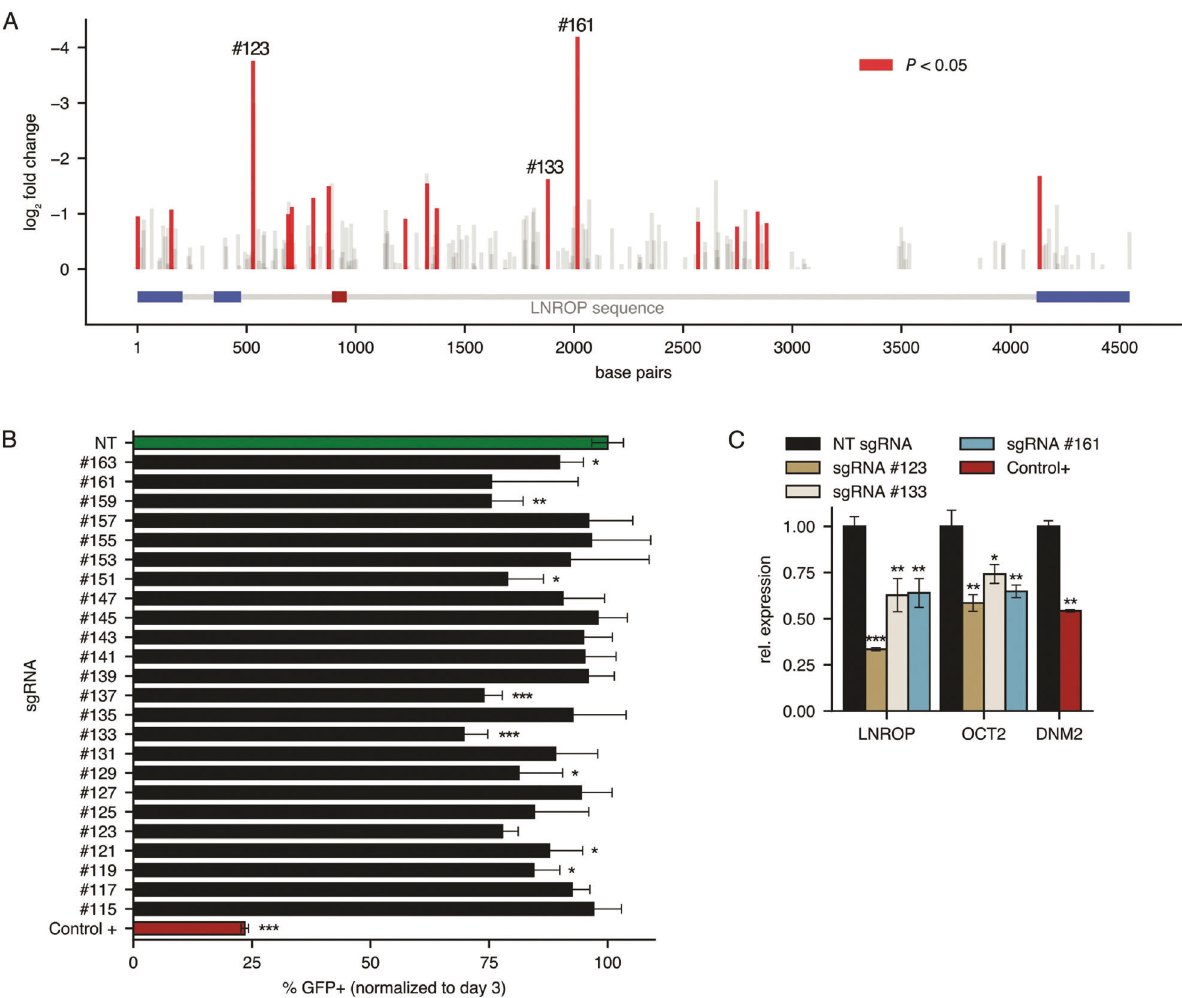
Fig. 2 Phenotypic characterization and OCT2 expression analysis after targeting LNROP using CRISPR-Cas9. A Schematic representation of the sgRNAs library used to target LNROP in RAMOS cells stably expressing active Cas9. Bars correspond to individual guides, and they are represented according to their position over LNROP sequence where introns are colored in grey, exons in blue and MIR4323 in red. Bar height corresponds to the log 2 fold change in guide abundance as measured by sequencing. Red bars indicate signi fi cantly depleted sgRNAs (P < 0.05). Guides (#123, #133 and #161) selected for subsequent experiments are labeled at their positions. B Phenotype characterization of RAMOS after standard CRISPR-Cas9 using sgRNAs targeting the LNROP sequence and expressed along with GFP. The number of GFP- expressing cells present in cultures was measured after 3 and 49 days using fl ow cytometry. Results indicate the change in the presence of GFP-expressing cells, using day 3 as starting point. A non-targeting guide (green) and a guide targeting DNM2 (red) were used as negative and positive controls, respectively. Data are mean ± SD of three replicates. C RT-qPCR analysis of LNROP and OCT2 expression in RAMOS cells after standard CRISPR-Cas9 using three sgRNAs (#123, #133 and #161) targeting the LNROP sequence or a non-targeting guide (NT). Data are mean ± SD of three replicates. * P < 0.05; ** P < 0.01; *** P < 0.001, unpaired t